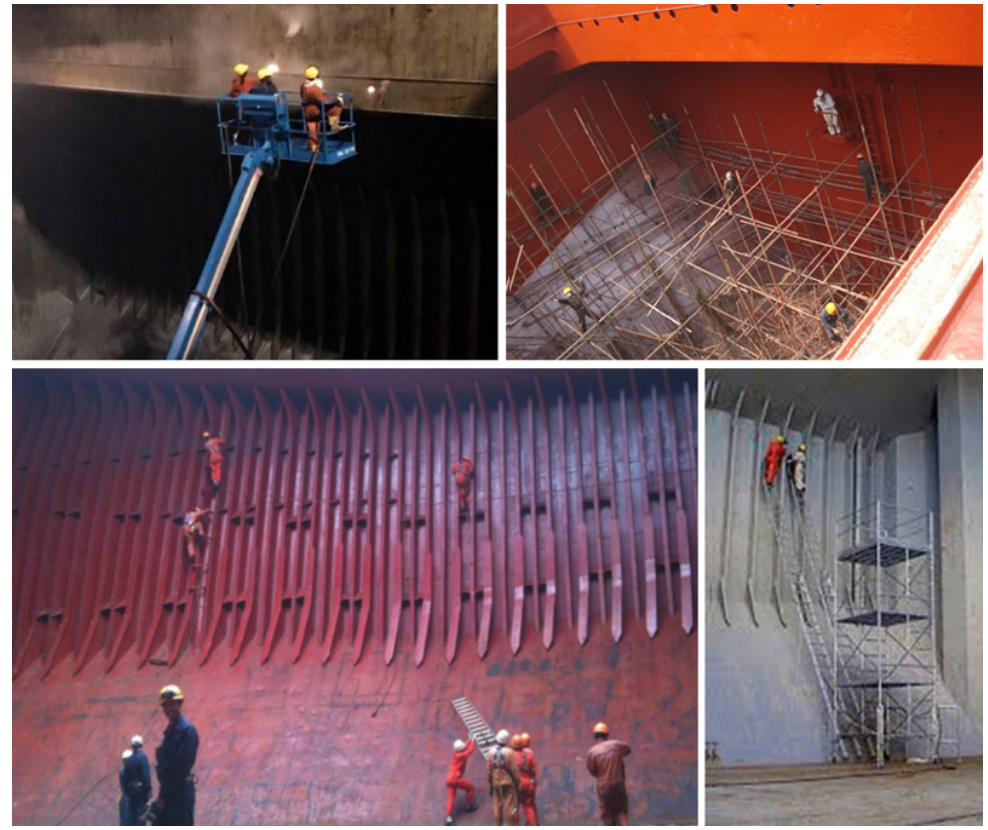
Figure 1. Access means to be arranged for close-up inspection in typical cargo holds: cherry pickers, scaffolding, portable ladders,